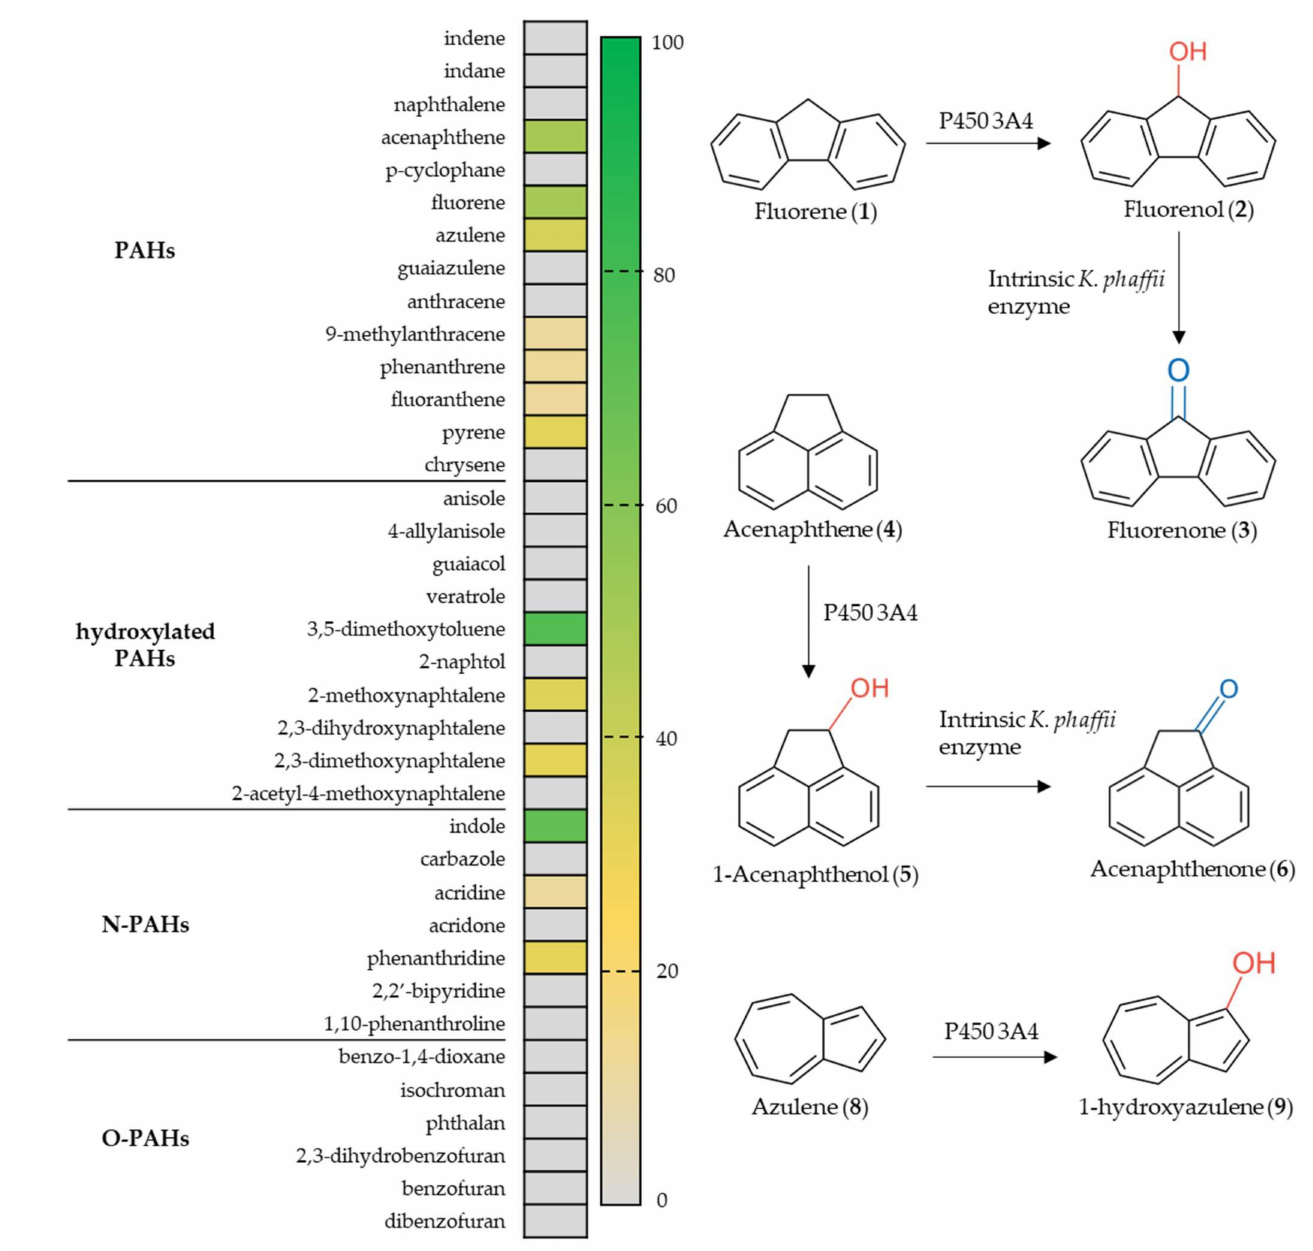
Figure 1. Screening of PAHs with CYP3A4. The heat map on the left indicates the conversion efficiency of P450 3A4 towards common PAHs, hydroxylated PAHs, as well as N - and O -containing PAHs. On the right, the synthetic fate of 1 , 4 and 8 upon K. phaffii whole-cell